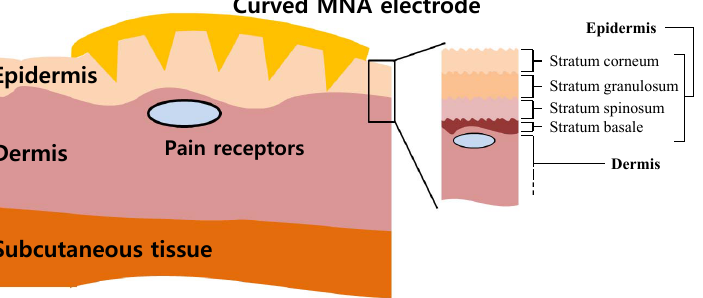
Figure 1. Structure of the skin with the microneedle array (MNA) electrode.